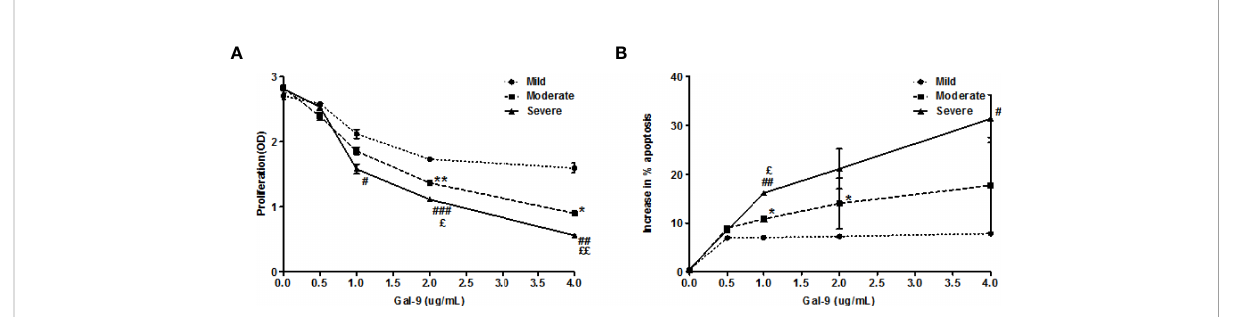
FIGURE 7 Gal-9 inhibits the proliferation and induces apoptosis in PBMCs from AD patients. (A) CCK-8 assay and (B) Apoptosis assay of PBMCs isolated from AD patients (Mild AD, n=11; Moderate AD, n=9; Severe AD, n=10) under graded doses of Gal-9 (0, 1.5, 5, 15, and 50 nM) and anti-CD3 (100ng/ml) for 72 h, respectively. These results are presented as means ± SEM. *P <0.05, **P <0.01, ***P <0.001 Mild AD vs . Moderate AD; #P < 0.05, ##P < 0.01, ###P < 0.001 Mild AD vs . Severe AD. z P < 0.05, zz P < 0.01, zzz P < 0.001 Moderate AD vs . Severe AD.